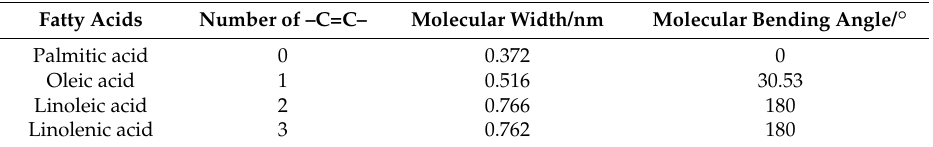
Figure 5. Molecular structure of ( A ) Palmitic acid, ( B ) Oleic acid, ( C ) Linoleic acid and ( D ) Linolenic acid in waste cooking oil. Table 2. Molecular width and molecular bending angle of fatty acid in waste cooking oil.